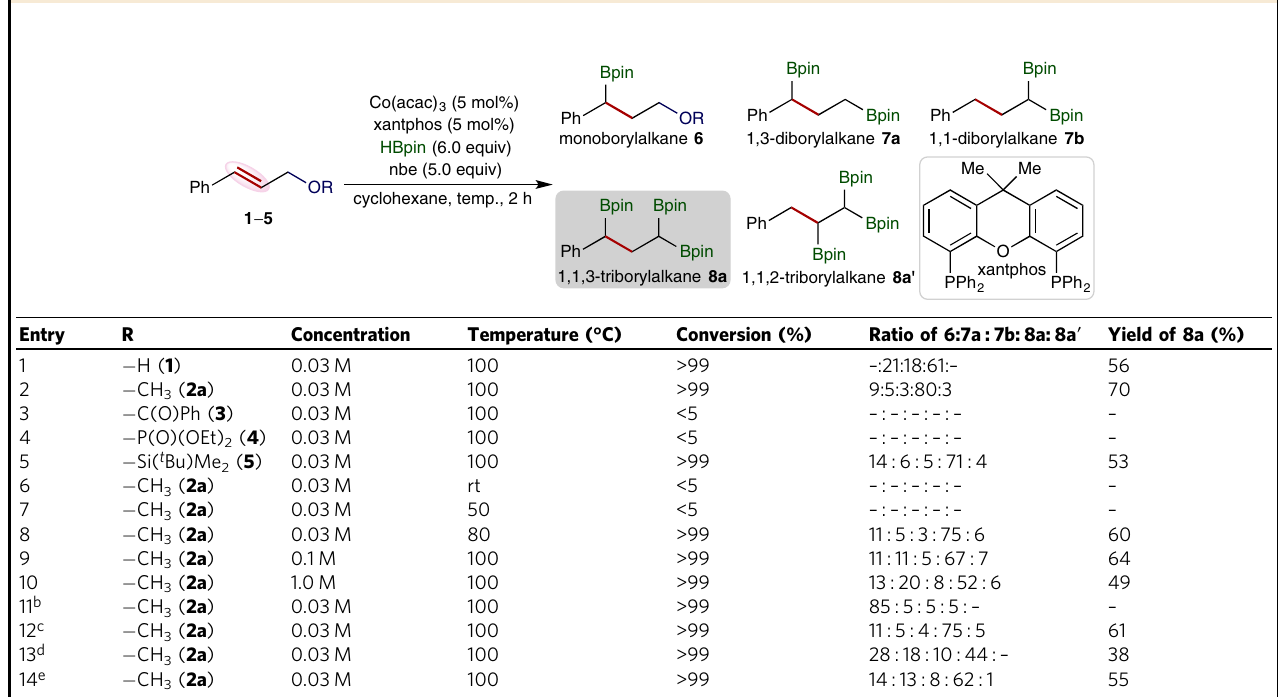
Table 1 Evaluation of conditions for the cobalt-catalyzed triborylation a